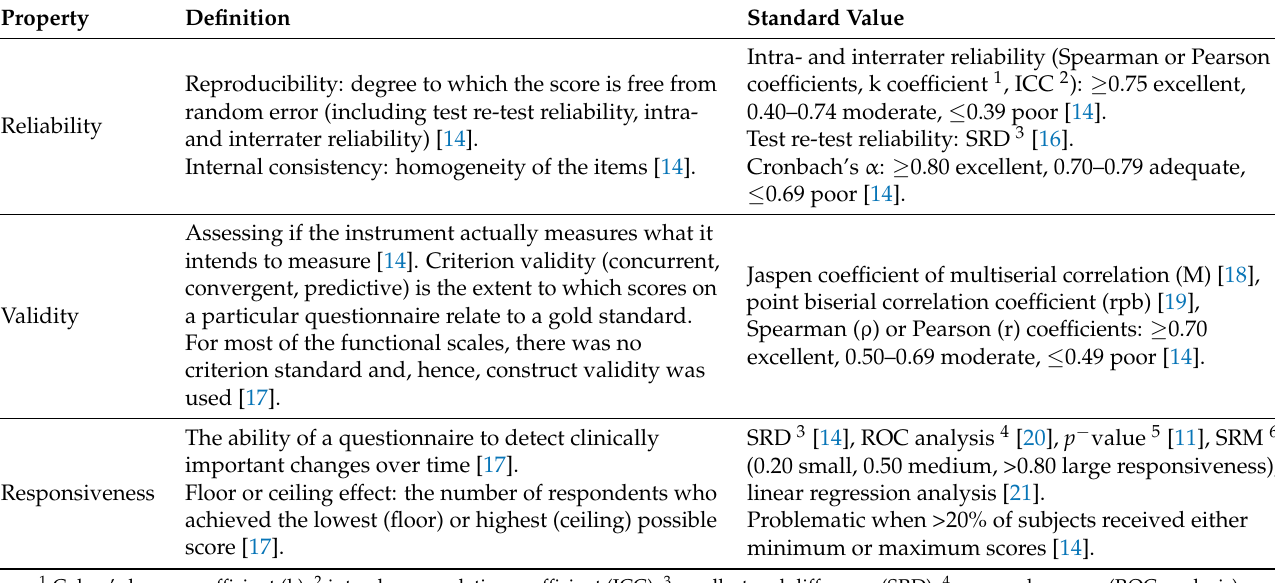
Table 1. Evaluation criteria and